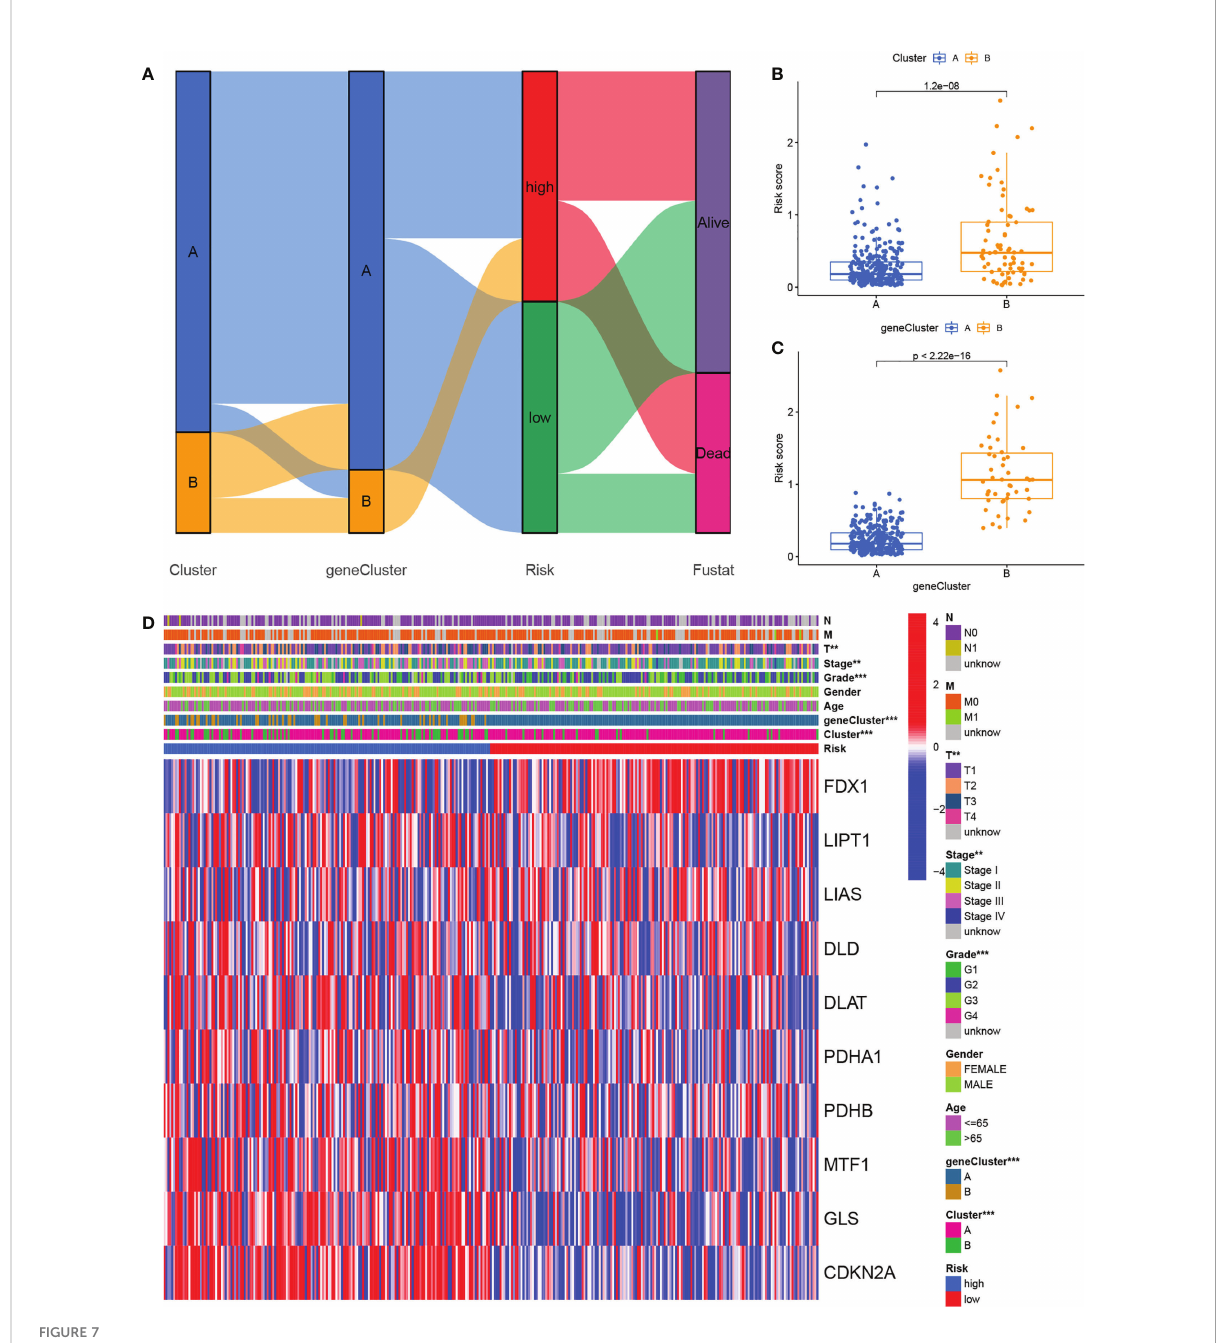
FIGURE 7 Relationship cross-links of cuproptosis clusters, gene clusters, risk signatures, and clinical features. (A) Alluvial diagram showing cuproptosis clusters, gene clusters, risk grouping, and survival status. (B) Risk scores in the cuproptosis clusters. (C) Risk scores in the gene clusters. (D) Heatmaps showing the integration of cuproptosis clusters, gene clusters, clinicopathological characteristics, and cuproptosis regulators ’ expression in relation to risk